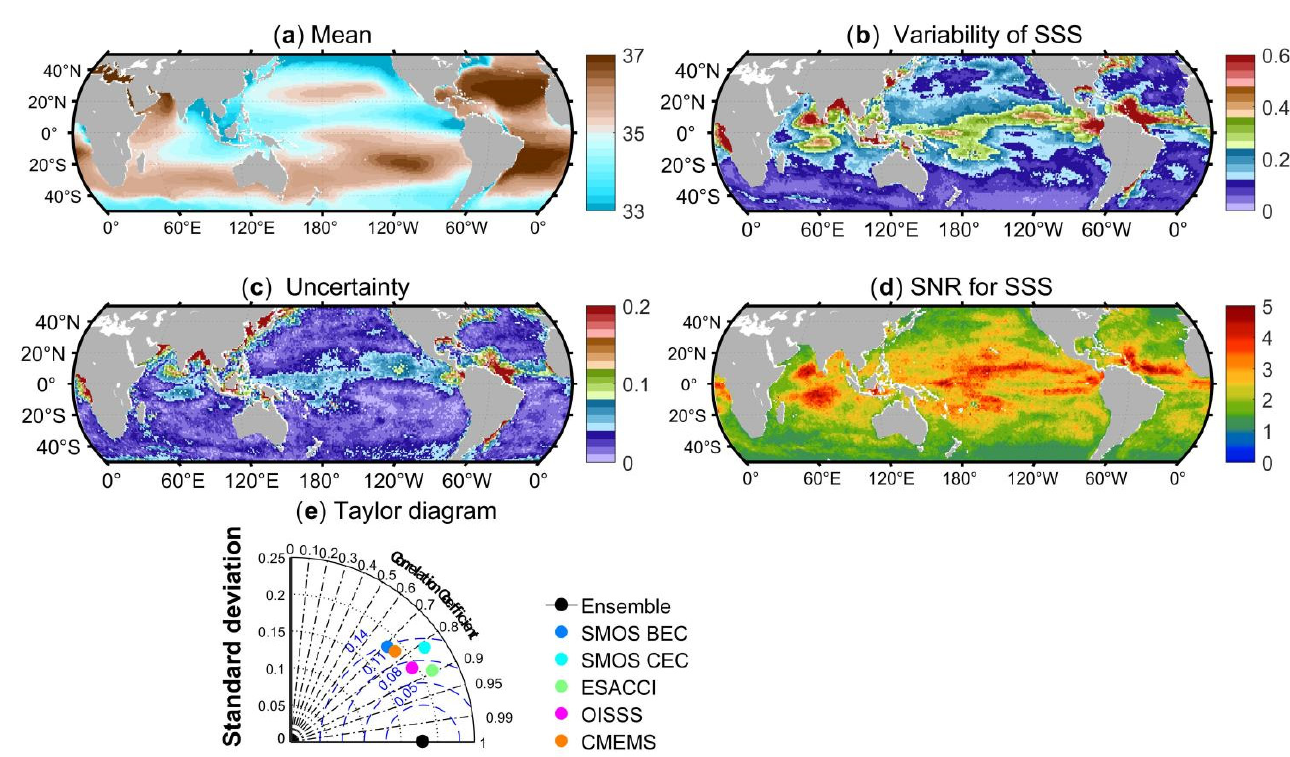
Figure 3. ( a ) Annual mean of ensemble median satellite-based SSS; ( b ) its variability; ( c ) uncertainty of variability in SSS; ( d ) signal-to-noise ratio in SSS variability; and ( e ) Taylor diagrams of area-weighted SSS from 2012 to 2017 over 50 ◦ S–50 ◦ N. p -value < 0.05 (58 degrees of freedom) for all correlations between individual SSS and its ensemble median. The units for mean SSS, variability, uncertainty, STD and RMSD are g/kg. The correlation coefficient and SNR are unitless.